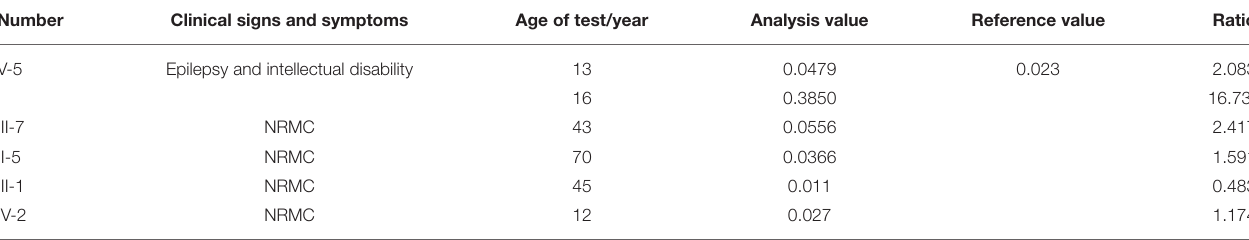
TABLE 1 | Value of urinary excretion of orotate of family members carrying uridine monophosphate synthetase (UMPS ) heterozygous